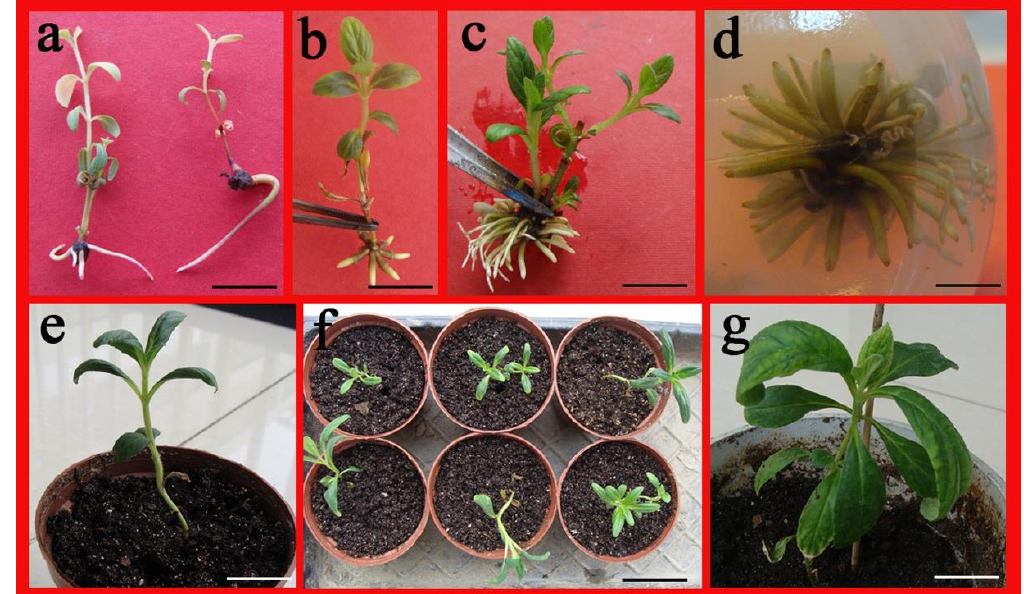
Data are presented as means ± standard deviations from three replicates with 30 explants in each replicate. Different letters within a column indicate significant differences according to Duncan’s multiple range test ( p < 0.05). All treatments included 1/2 MS medium. + indicates root formation, and—indicates roots were not formed yet within the observed time period.